Question: Draft a figure caption describing what is shown.
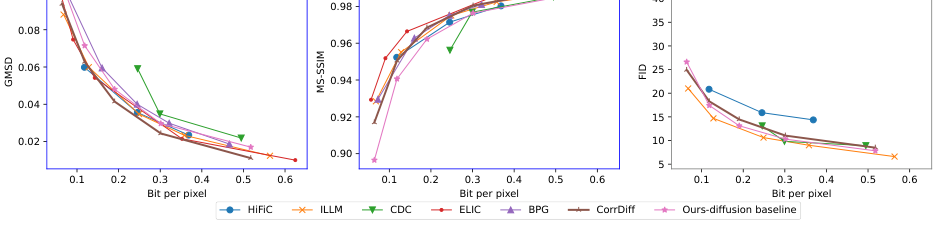
Answer: performance of diverse metrics on CLIC professional dataset. [Zoom in for best view]